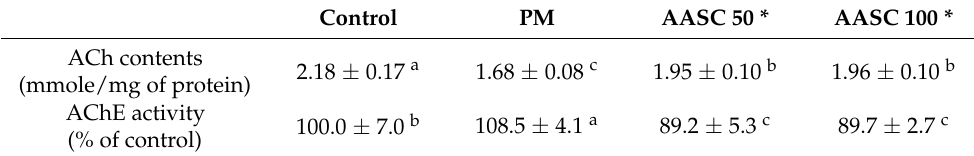
Table 2. Effect of AASC on the cholinergic system in serum of mice exposed to PM 2.5 . Control